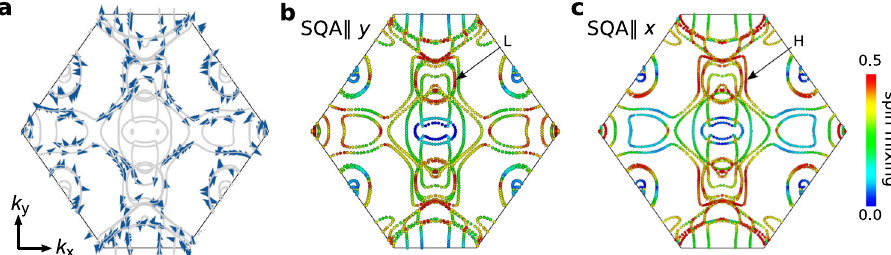
on the Fermi b ^ s